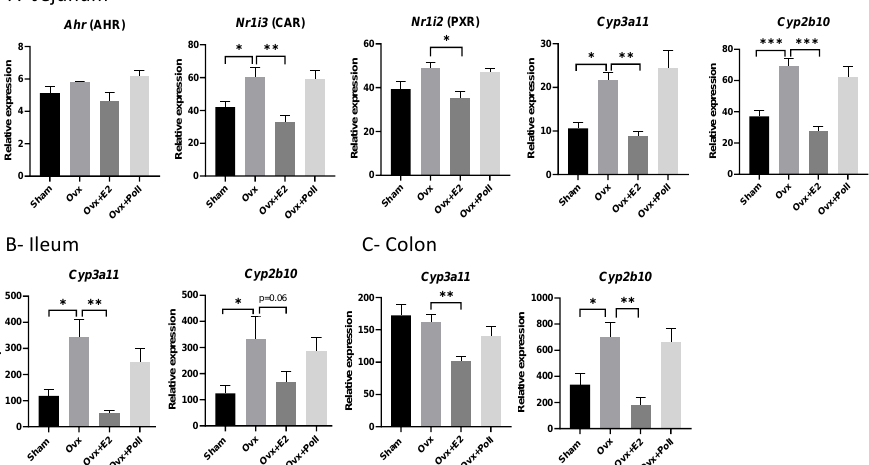
Figure 2. Effect of ovariectomy alone (Ovx) or with 17 β -estradiol (E2) supplementation (Ovx+E2) or with exposure to pollutants (Ovx + Poll) on the expression of genes encoding xenobiotic processing genes including the xenobiotic receptors (AHR, PXR, and CAR) and the CYP3A11 and CYP2B10 in the jejunum ( A ); the CYP3A11 and CYP2B10 in the ileum ( B ) and the colon ( C ). Values are means ± SEM with n = 6–8. *** p < 0.001; ** p < 0.01; * p < 0.05. Sham: Sham-operated mice.